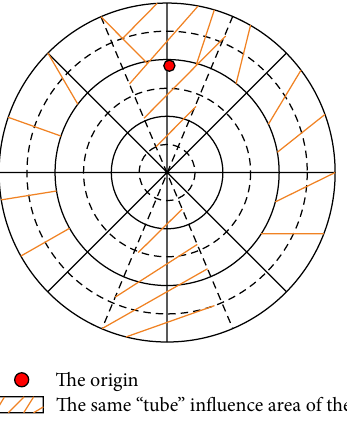
Figure 9: The same influence “tube” area of an